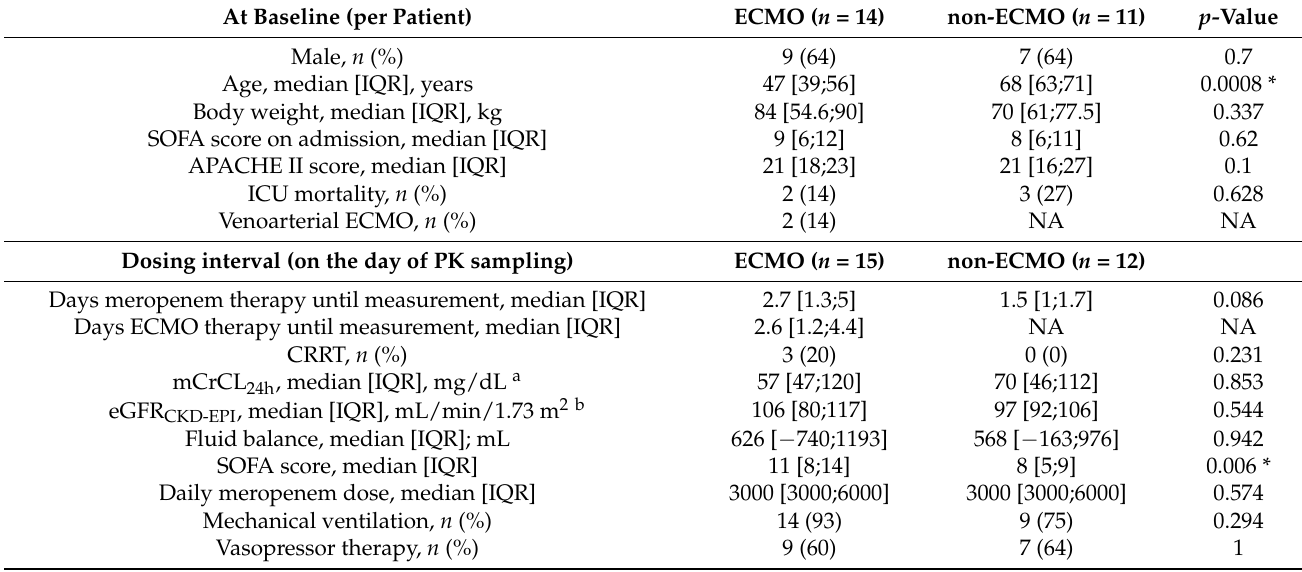
Table 1. Clinical